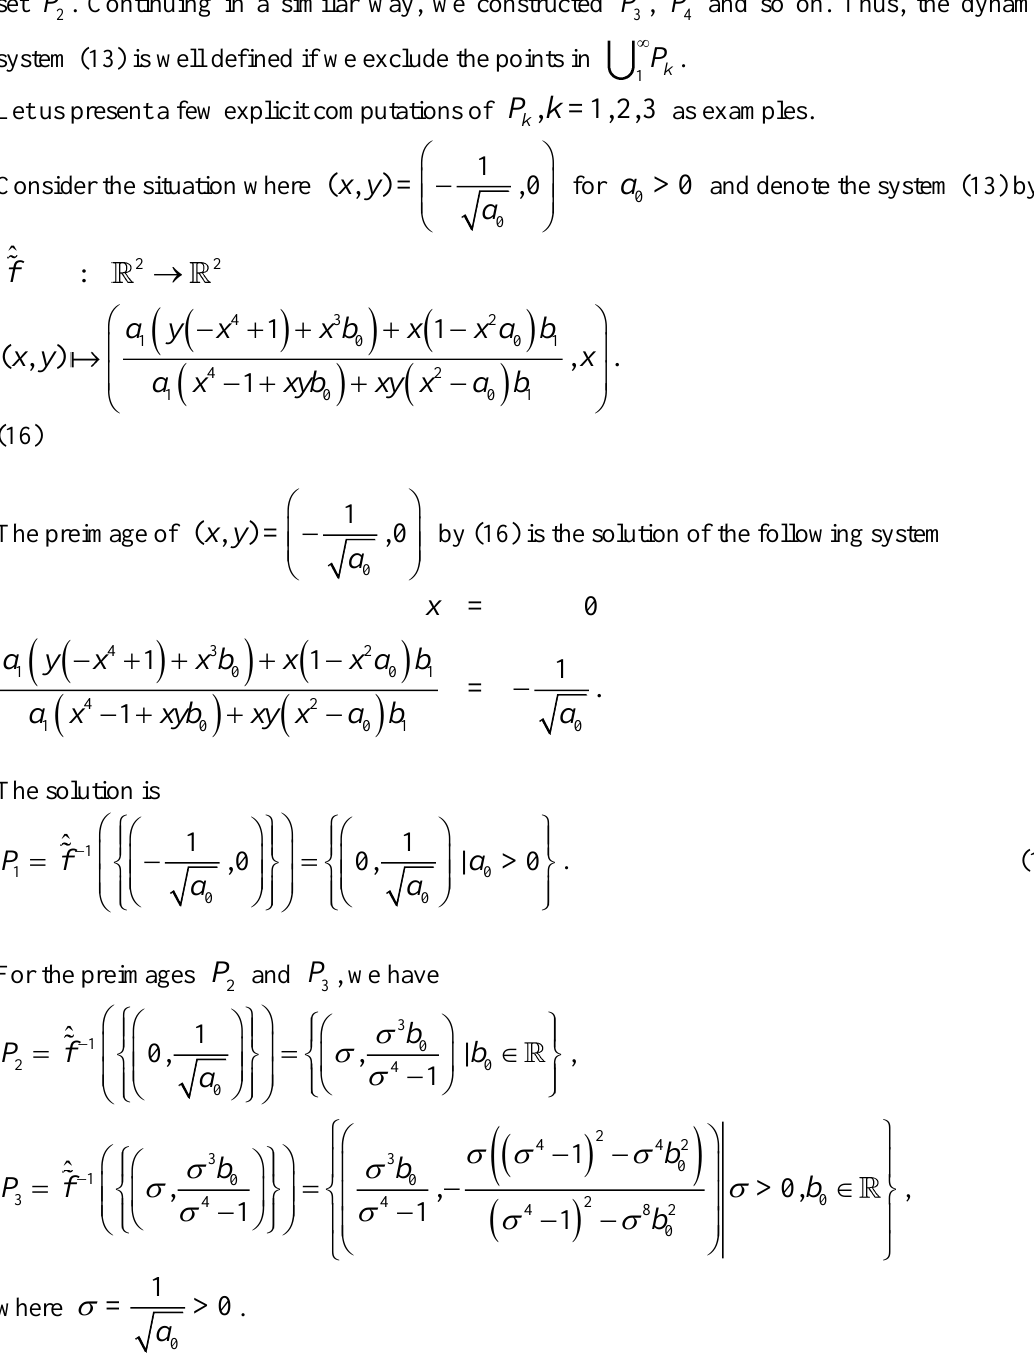
P are plotted using green, red, blue, orange, and black, respectively. It is interesting to note that 6